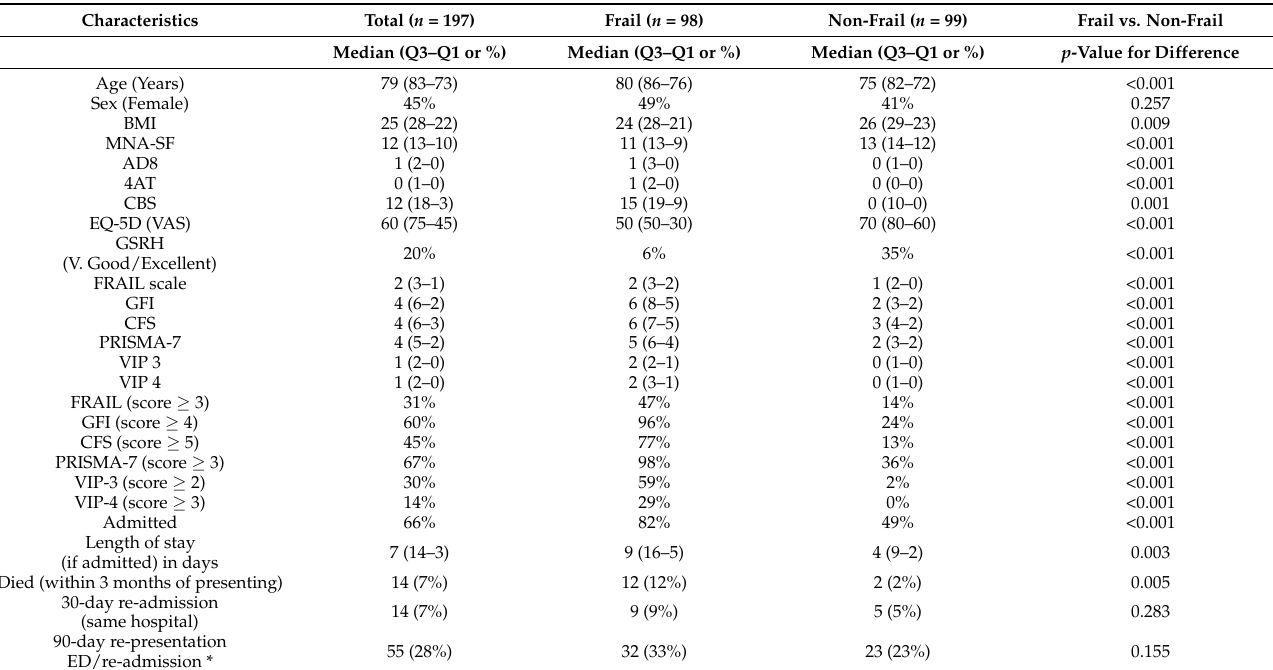
Table 1. Characteristics of patients ( n = 197) screened for frailty comparing those classified as frail and non-frail based on the comprehensive geriatric assessment classification.